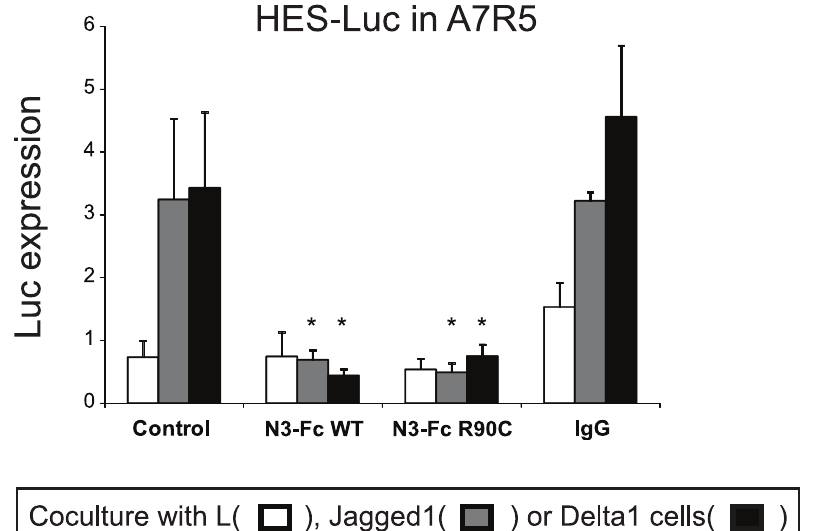
Figure 8. Inhibition of Notch signaling by extracellular NOTCH3 ectodomain. As in Figure 7, A7R5 cells (n=3 replicate wells per group) transfected with HES-luciferase reporter (but not NOTCH3 cDNA) were cocultured with ligand producing or control cells. Experiments were performed in the presence of 1 ug/ml (3 nM) recombinant NOTCH3-Fc protein (wildtype or R90C mutant ectodomains fused to Fc). Control studies were done with no added protein and with purified human IgG to control for the presence of immunoglobulin in the NOTCH3-Fc preparation. * indicates differences between NOTCH3-Fc treated cells versus control cells (p , 0.05). Experiments were done three times with similar results.